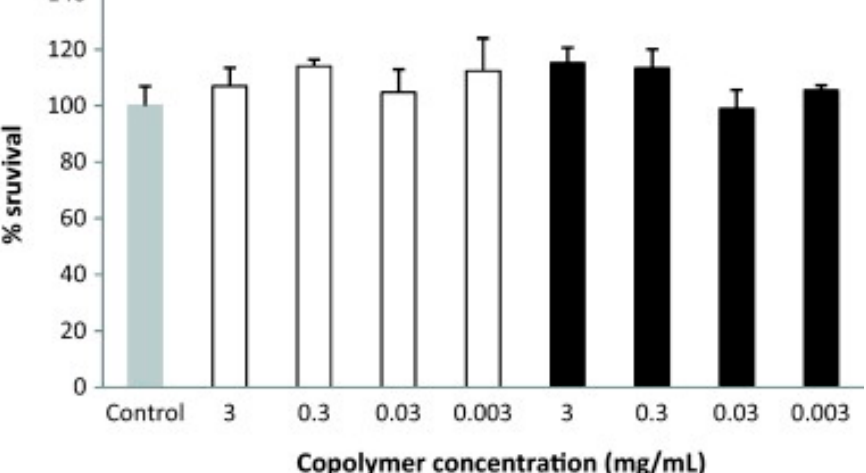
Figure 7. Cell viability of human corneal epithelial cells (HCE) when treated with different concentrations of blank ( white columns ) and cyclosporine A-loaded micelles ( dark columns ) [107]. Reprinted from [107]. Copyright (2018), with permission from